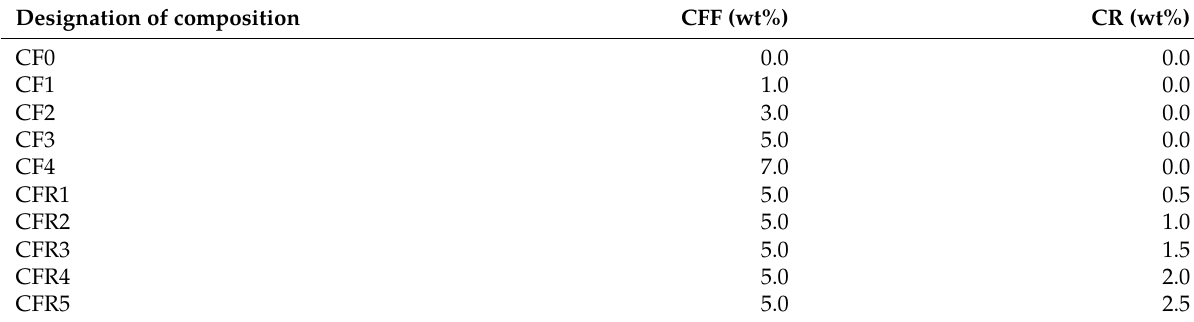
Table 2: Designations of compositions.